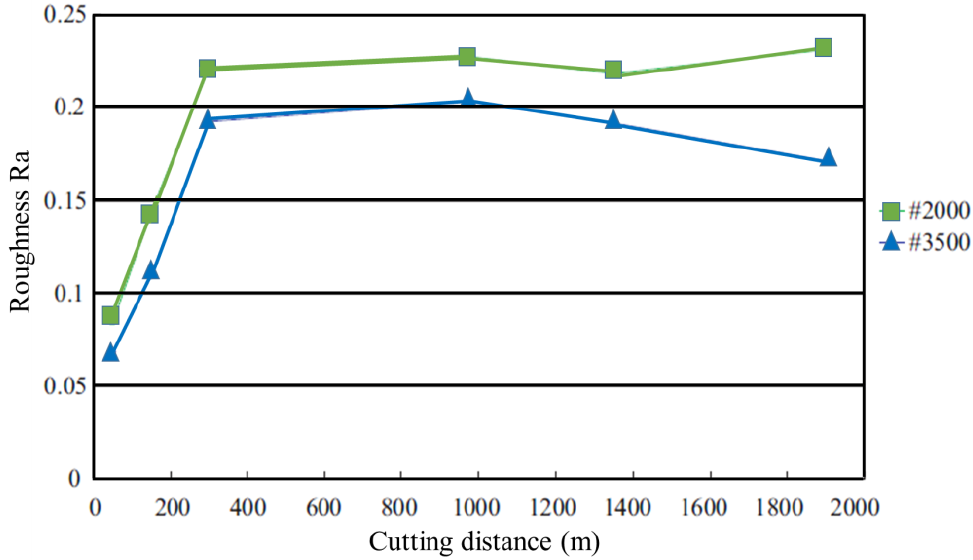
Figure 13. Variation of blade surface roughness vs. cutting distance. Adapted with permission from Ref. [62]. 2014, Elsevier.